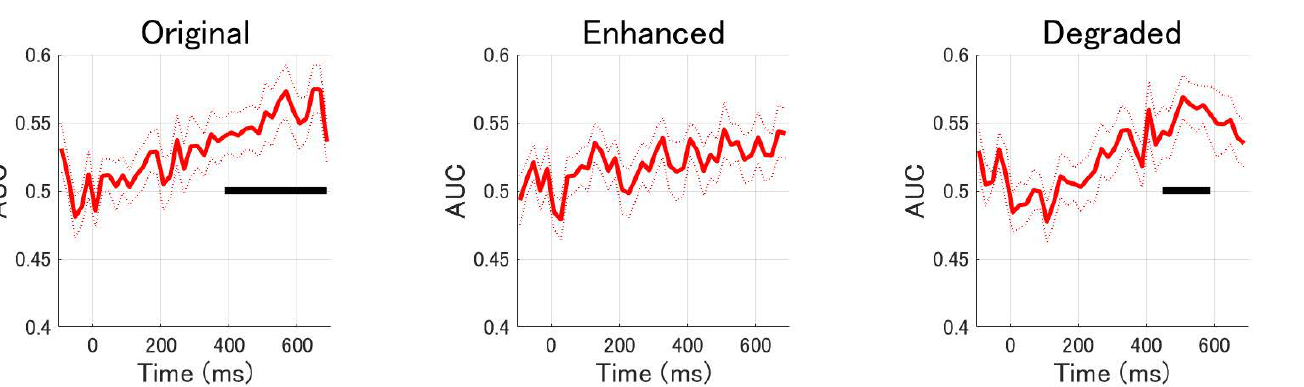
Figure 7. Temporal course of AUC for classification of self and other familiar faces in each condition. The black thick horizontal bar at the level of AUC = 0.5 represents the temporal window during which AUC was determined to be statistically above chance level by cluster – permutation statistics. The dotted lines represent standard errors.